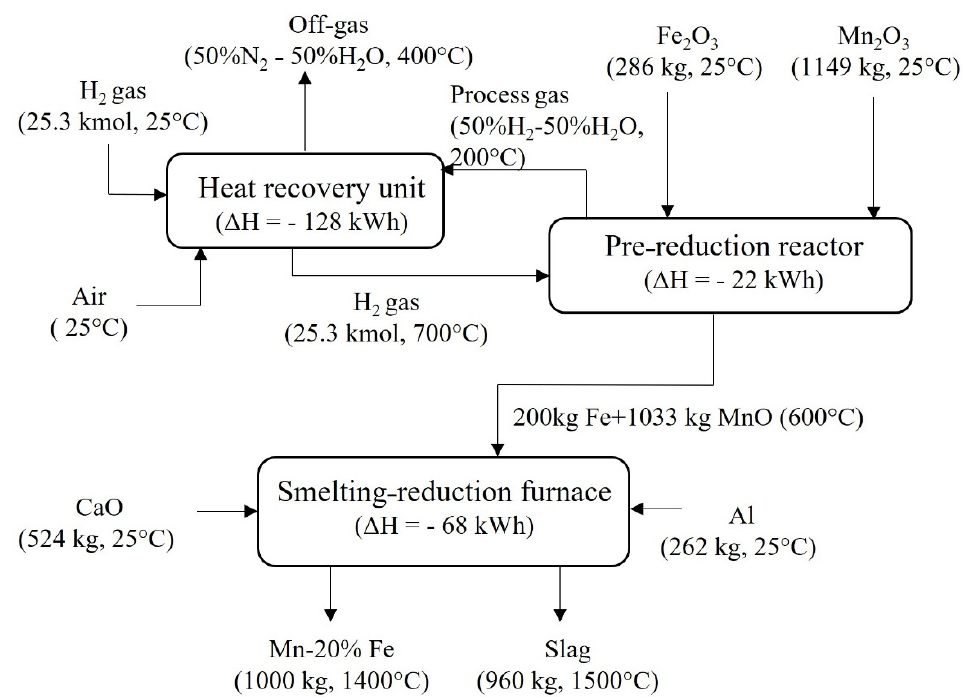
Figure 11. Mass and energy balances for the different units of HAlMan process for Green FeMn production via process illustrated in Figure 6a.